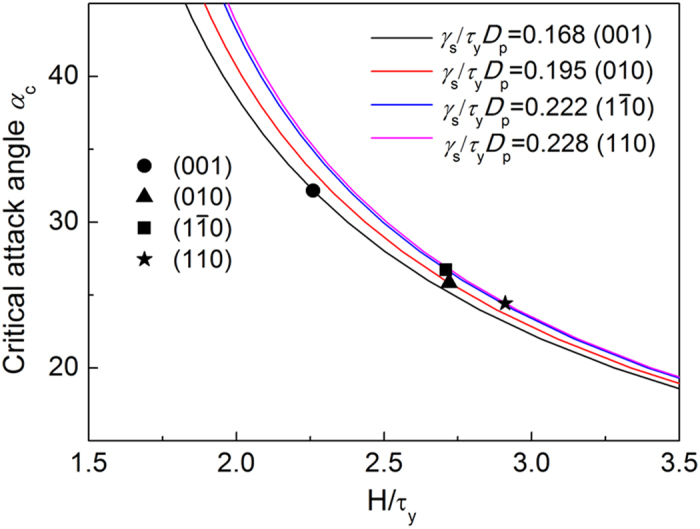
Dependence of αc on H/τy for given γs/τyDp.